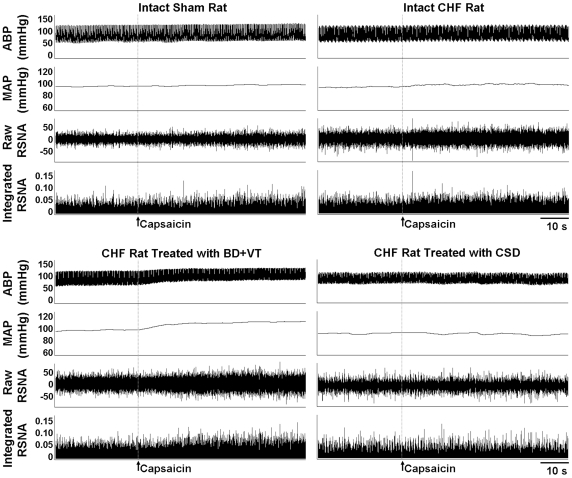
Representative tracings showing the CSAR induced by epicardial application of capsaicin in intact Sham rat, intact CHF rat, BD+VT-treated CHF rat and CSD-treated CHF rat.BD+VT, baroreceptor denervation plus vagotomy; CSD, cardiac sympathetic denervation.